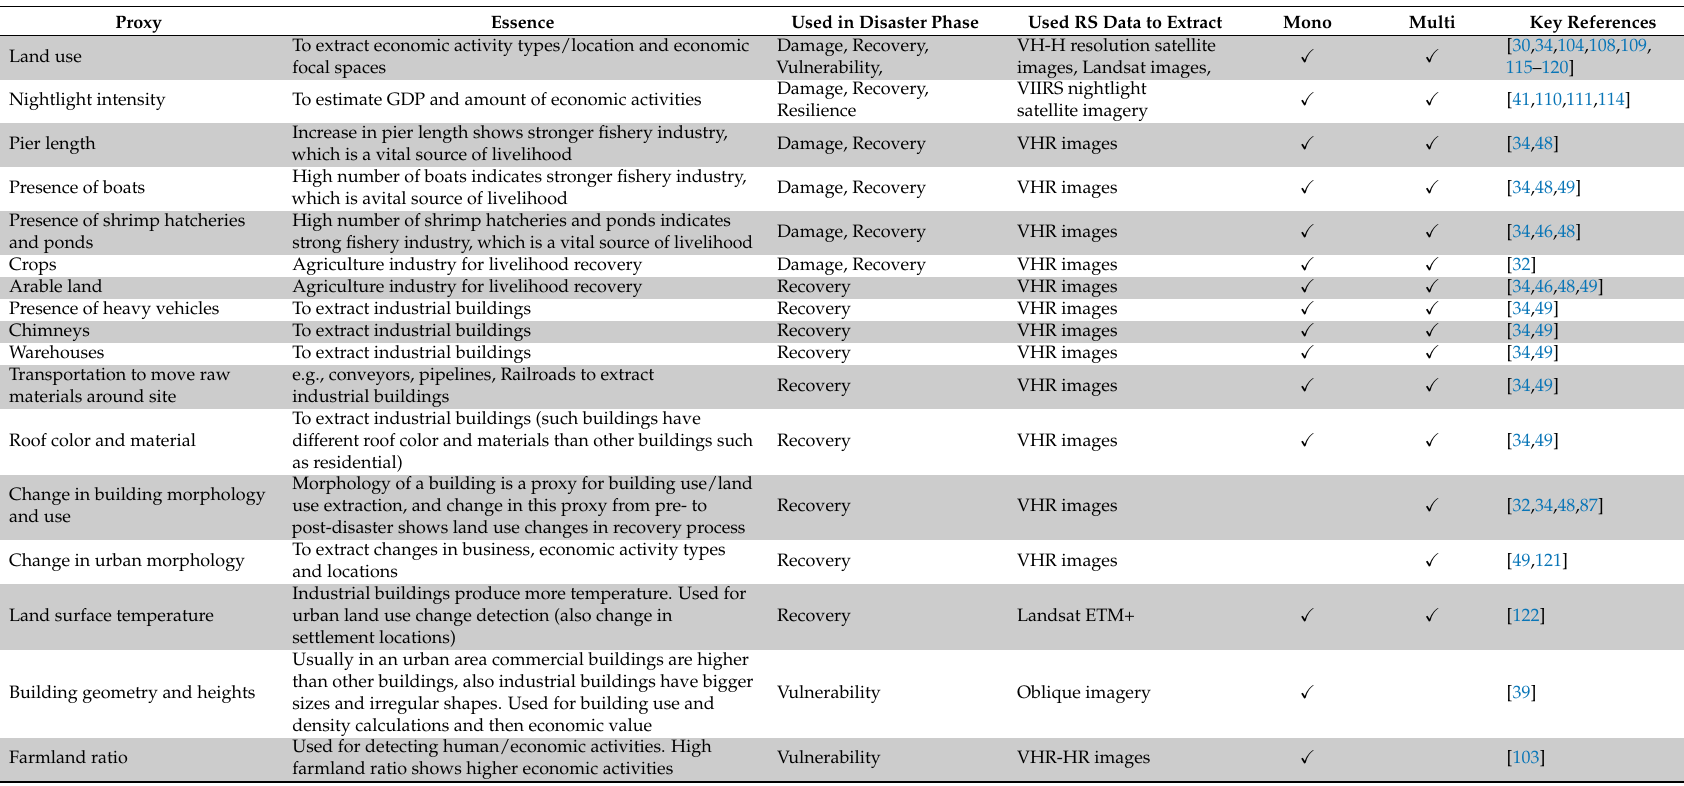
Table 4. Remote sensing-based economic proxies for urban DRM, Macro, regional, and urban economics category. Mono and Multi refer to mono-temporal and multi-temporal RS data that used for extraction,